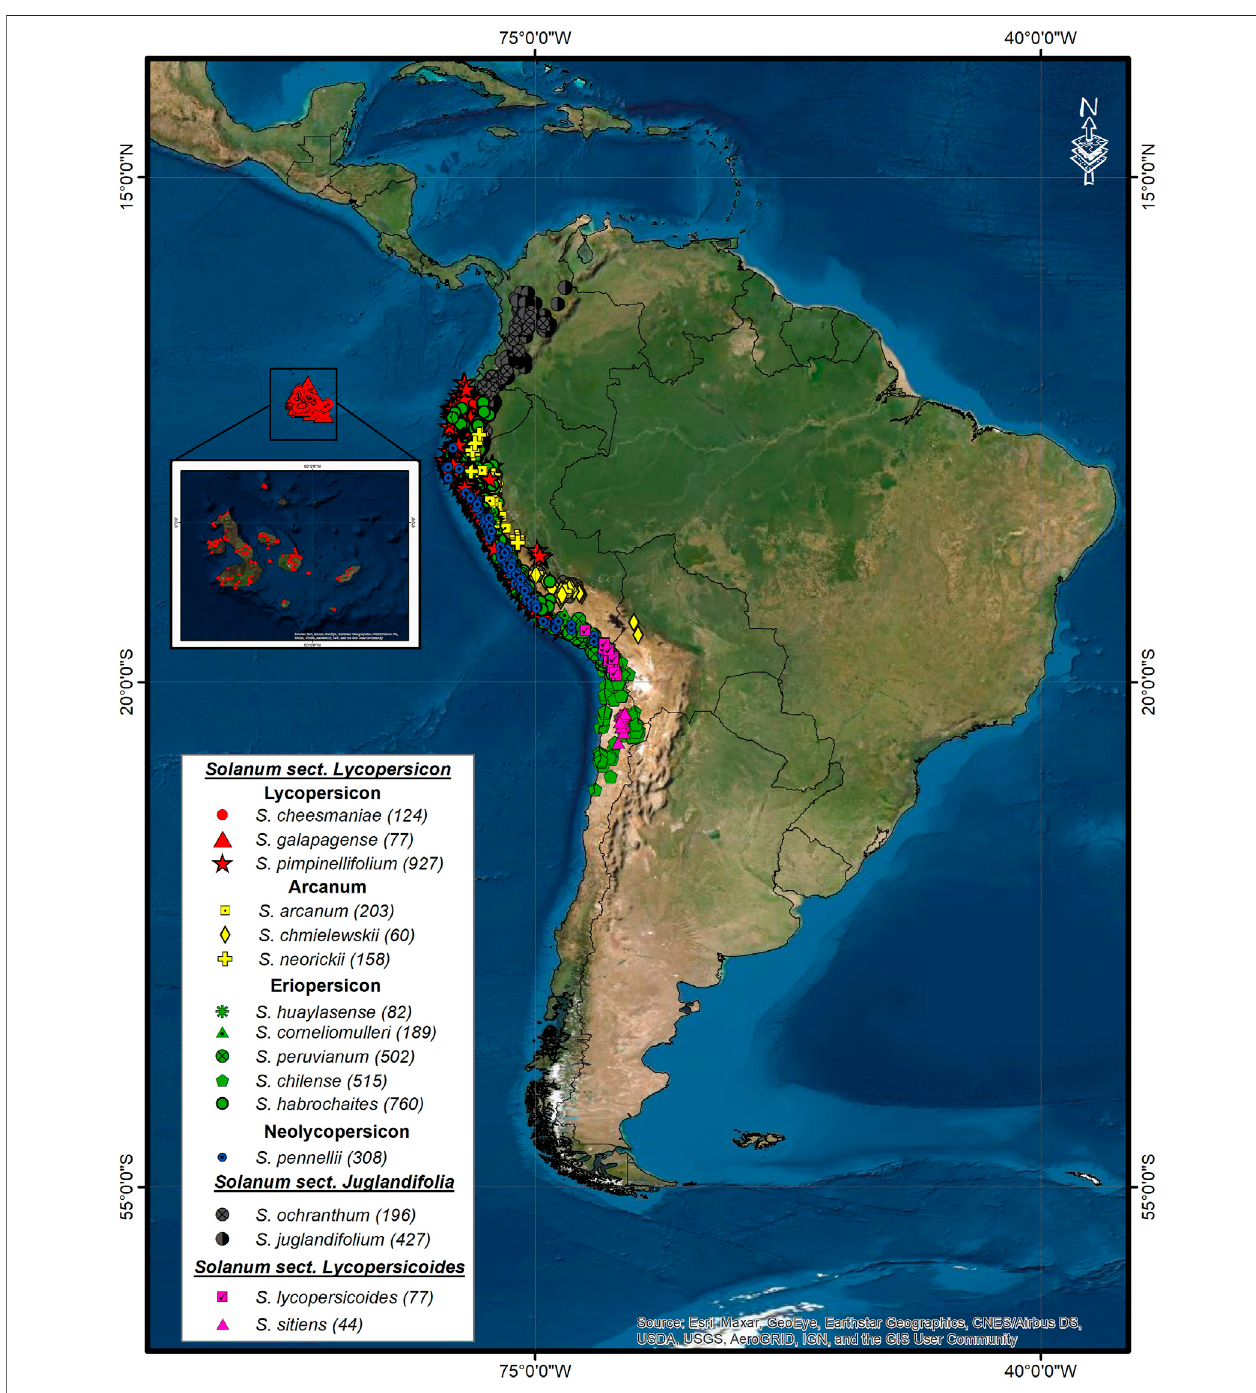
FIGURE 1 | Geographic distribution of 12 wild tomato ( Solanum sect. Lycopersicon) and 4 closely related species ( Solanum sect. Juglandifolia, and Lycopersicoides). In parenthesis, number of accessions after each species name.